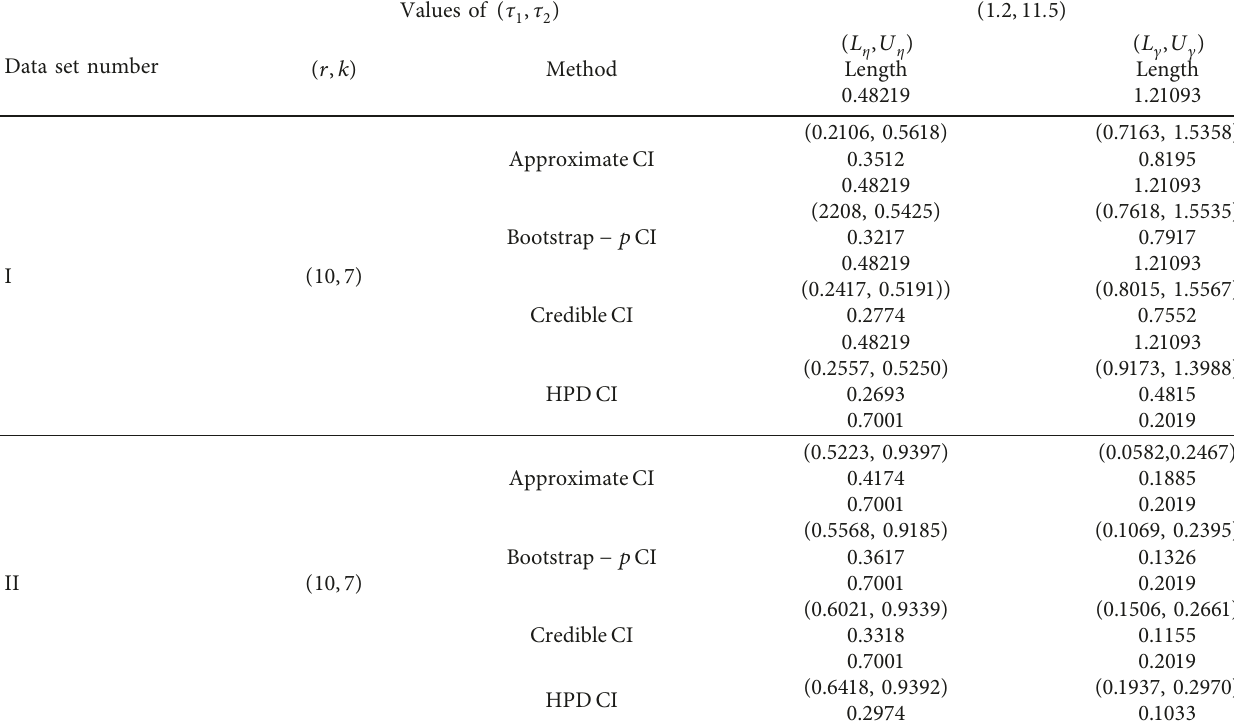
Table 4: Parameters estimates based on UPHCS from real data set I and